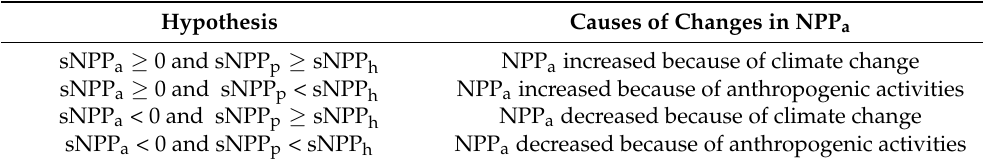
Table 2. Causes of changes in NPP a . Hypothesis Causes of Changes in NPP